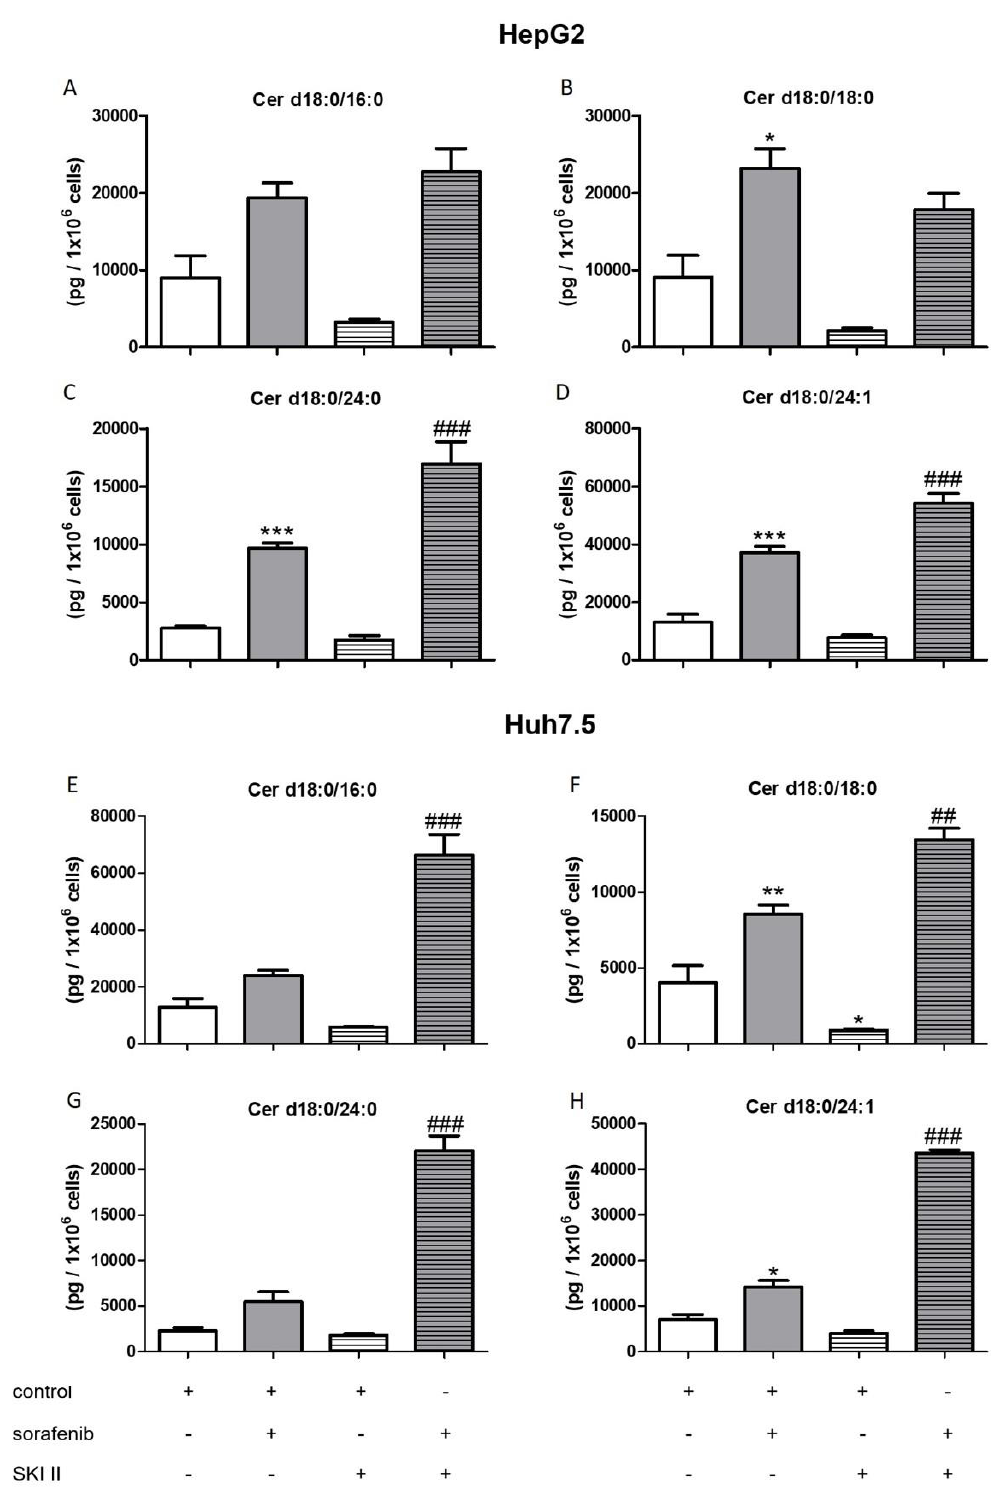
Figure 5. Influence of sorafenib and SKI II inhibitors on concentrations of dihydroceramides in HepG2 and Huh7.5 cells. The lipids were measured by LC-MS / MS. The cells (HepG2 in ( A )–( D ) and Huh7.5 in ( E )–( H )) were treated with or without 10 µ M SKI II for 2 h before the addition of vehicle (control; 0.2% DMSO) or 5 µ M sorafenib and further incubation for 24 h. All results are presented as means ± SEM of three independent experiments. * p < 0.05, ** p < 0.01, *** p < 0.001 compared to control; ## p < 0.01, ### p < 0.001 compared to sorafenib in one-way ANOVA followed by Bonferroni post-tests.